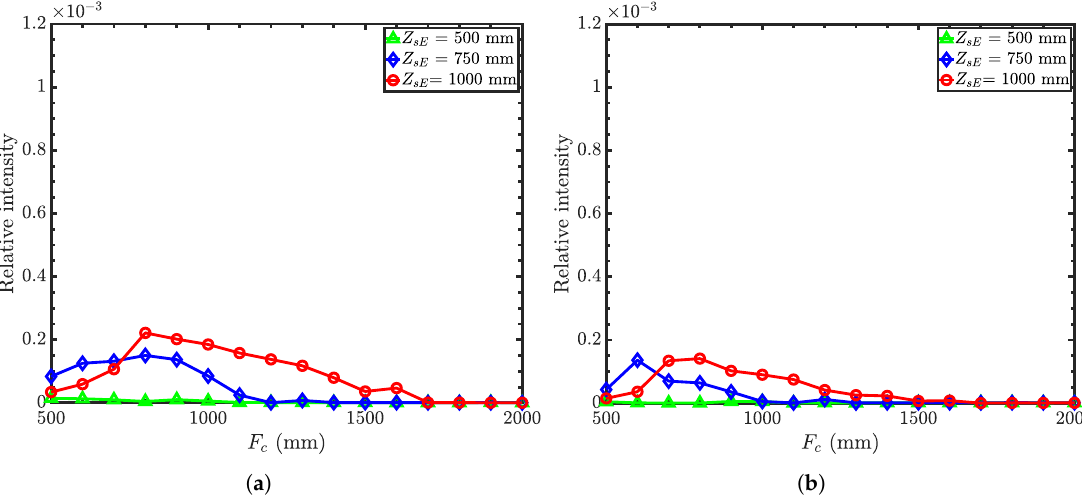
Figure 8. Relative intensities for the Wolter II microscope as a function of condenser focal length with an objective focal length of 500 mm, 750 mm, and 1000 mm. ( a ) Guide-to-condenser distance GCD = 500 mm; ( b ) GCD = 1000 mm. Simulations used 10 6 rays. Here, the working distance is Z sE . The vertical scale is the same as in Figure 4 for the ease of